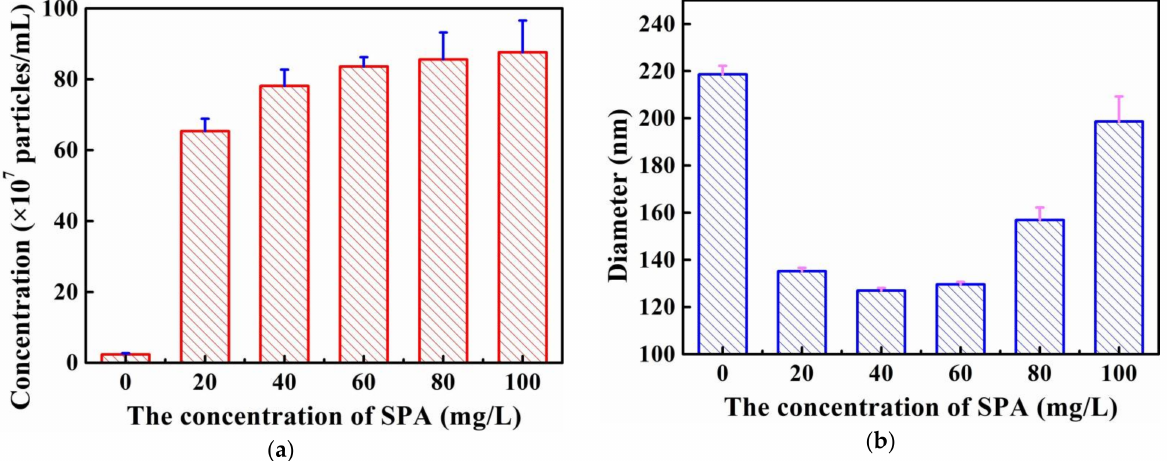
Figure 1. The concentration ( a ) and diameter ( b ) of nanobubbles vary with the concentration of